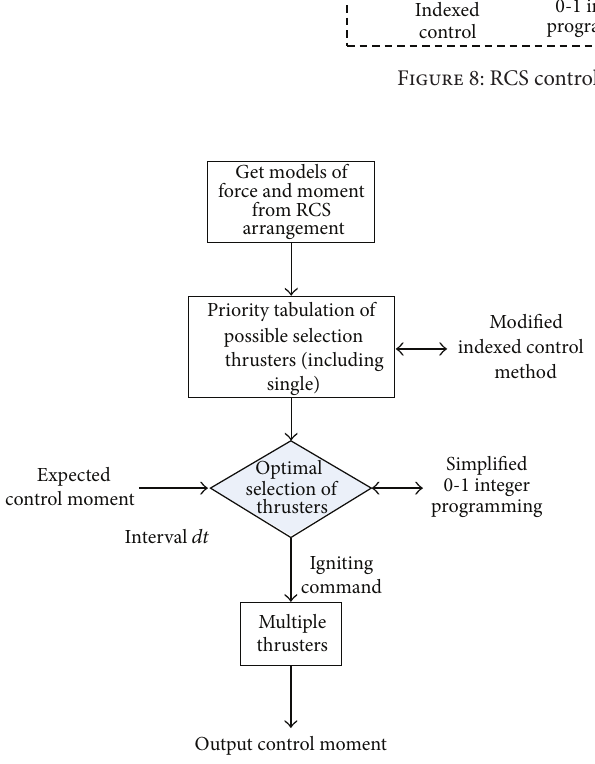
Figure 9: RCS control allocation flow diagram.